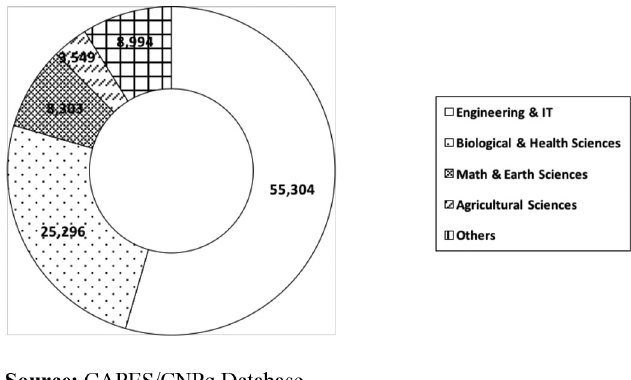
Figure 7. Science